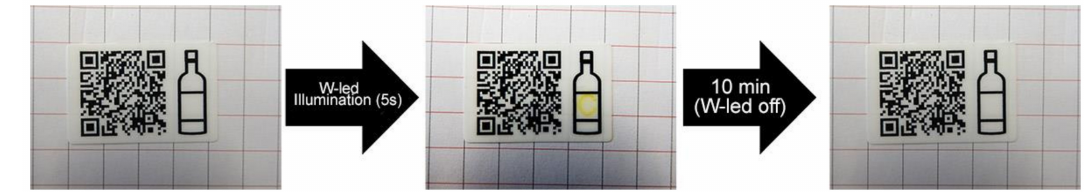
Figure 17. Activation of a SmartTag based on reversible W-LED-sensitive photochromic sensor.